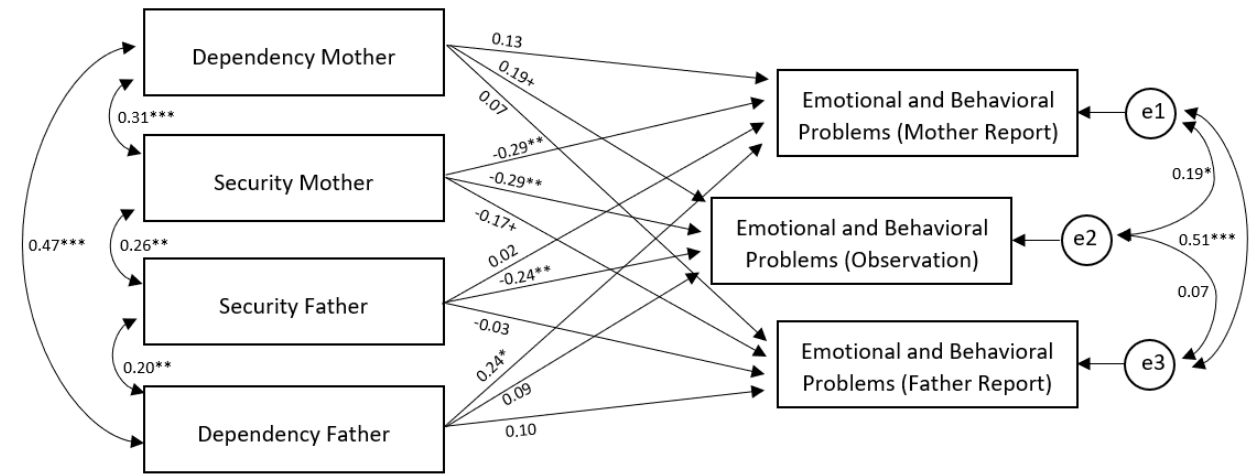
Figure 2. Actor and Partner Effects of Child-Parent Attachment on Parental Reports and Objective Observation of Emotional and Behavioral Problems. Note: *** p < 0.001, ** p < 0.01, * p < 0.05, + p < 0.10.